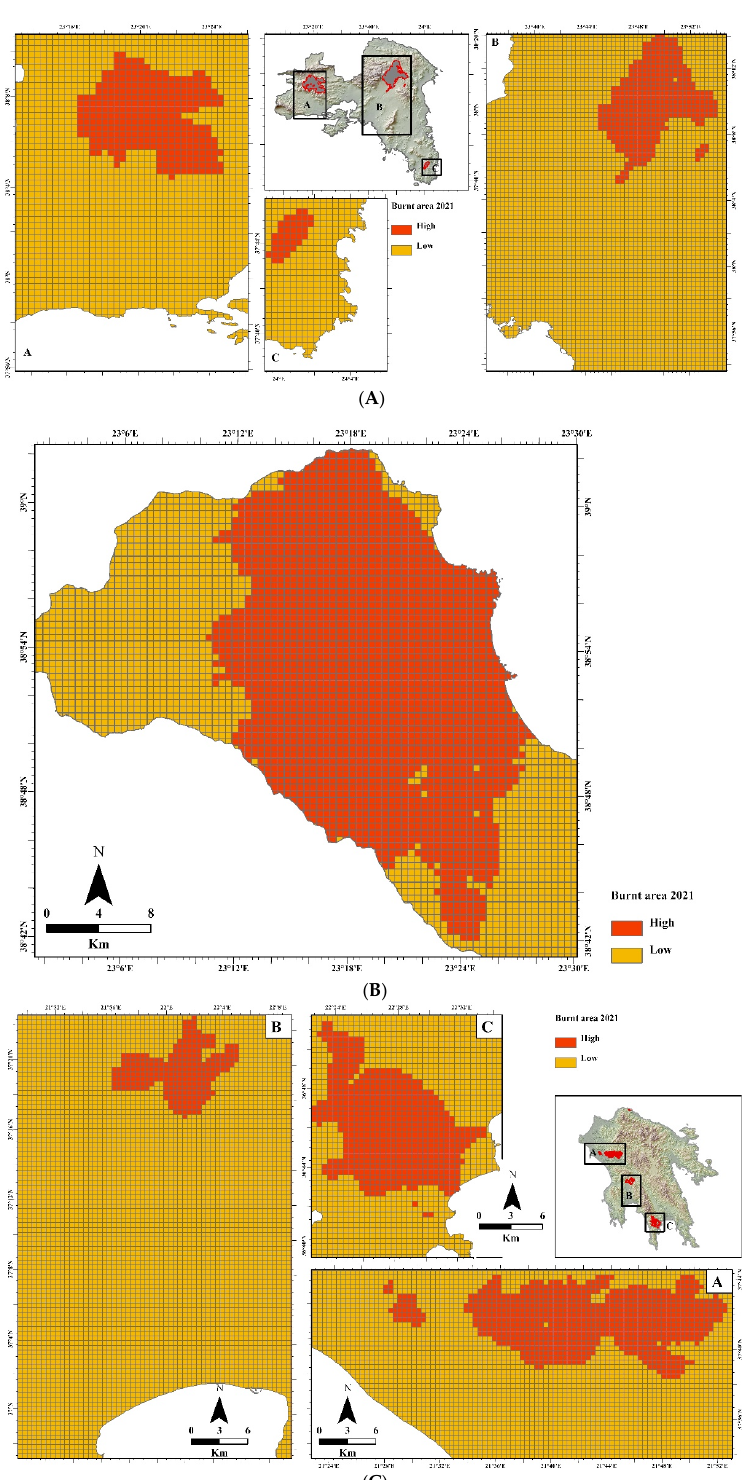
Figure 7. Fire-affected areas receiving high values in the Boolean logic rules: ( A ) Attica, ( B ) Euboea, and ( C ) Peloponnese.